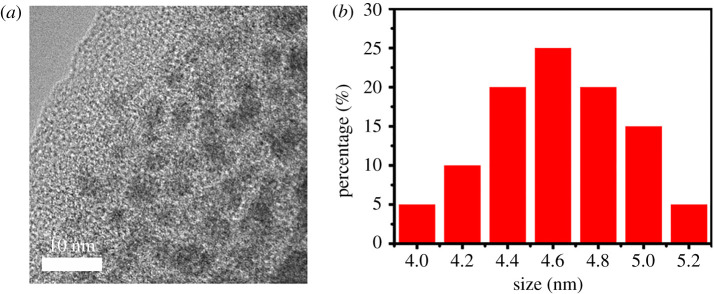
(a) HR-TEM and (b) DLS of Ag2S CDs.